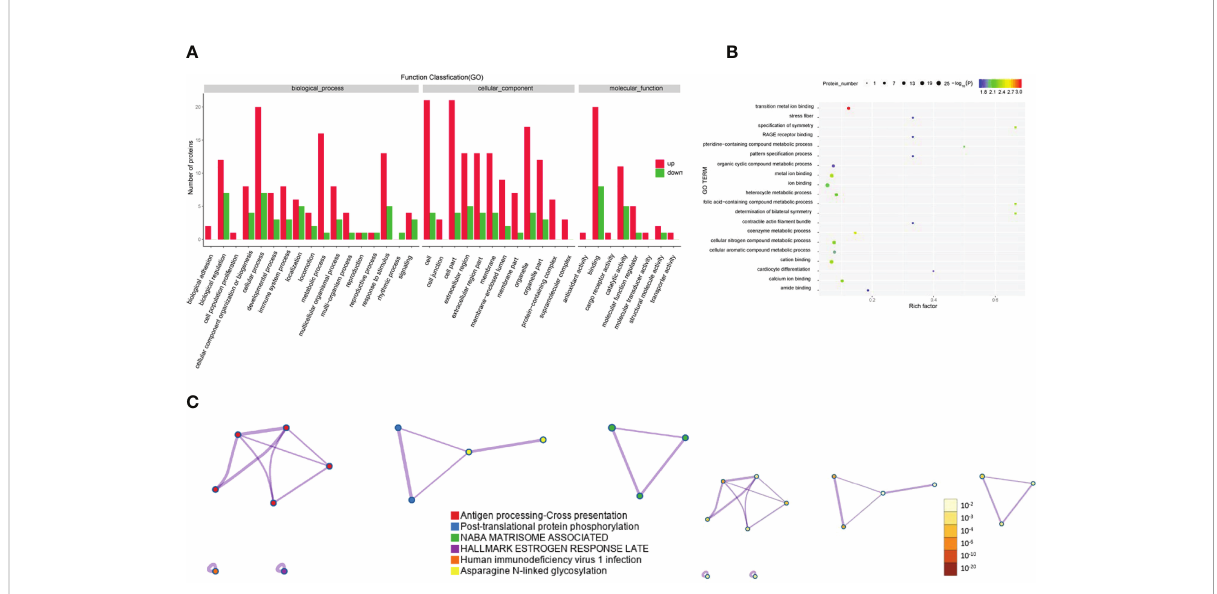
FIGURE 5 Gene Ontology and KEGG analyses of differentially expressed proteins from the GO group and the healthy control group. (A-C) Gene Ontology annotation (A) , Gene Ontology enrichment (B) , and KEGG enrichment (C) analyses of differentially expressed proteins in exosomes from the GD group and healthy